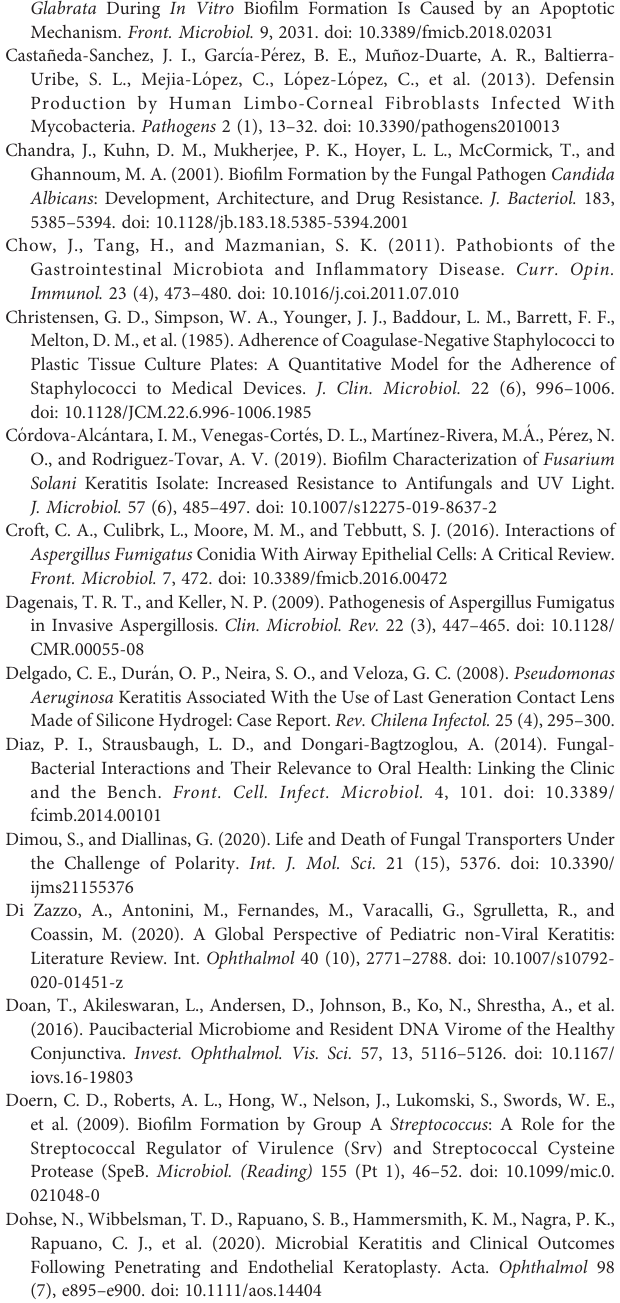
Nucleolus; Ci, Cytoplasmic inclusions; Mv, Microvesicles.